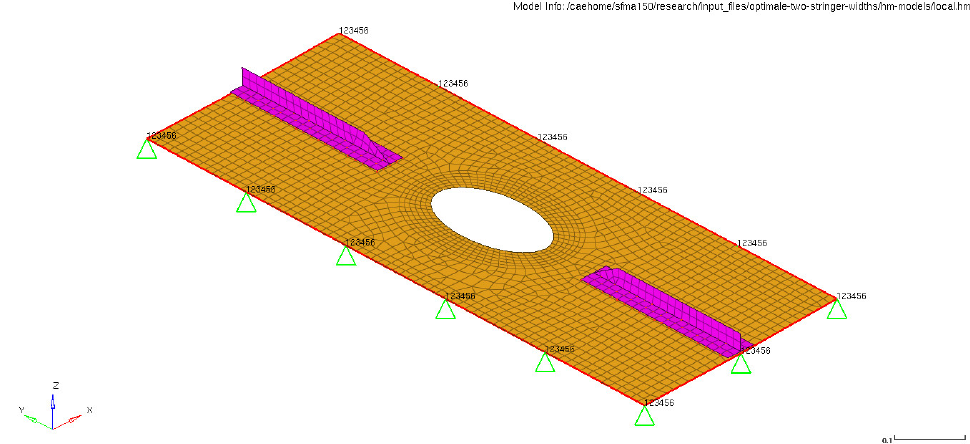
Figure 22. Detailed representation of the non-regular area.